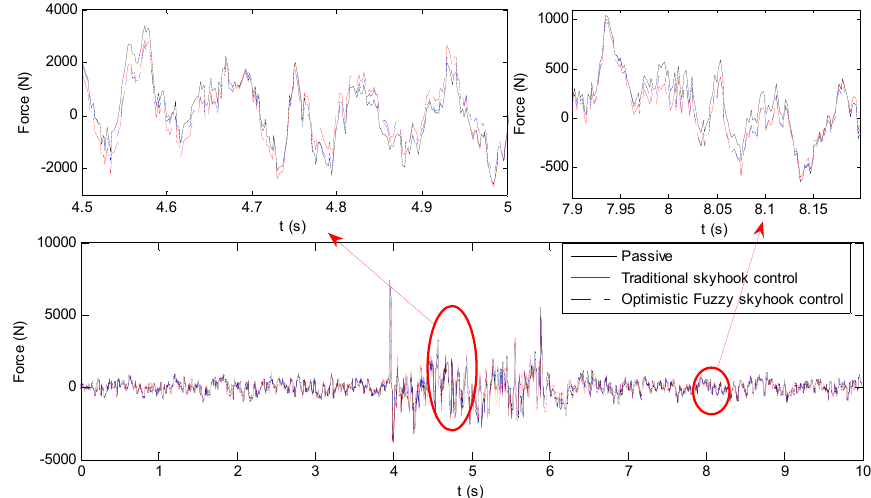
Figure 22. Comparison of the tire dynamic loads of using the three control methods under potholed road excitation.